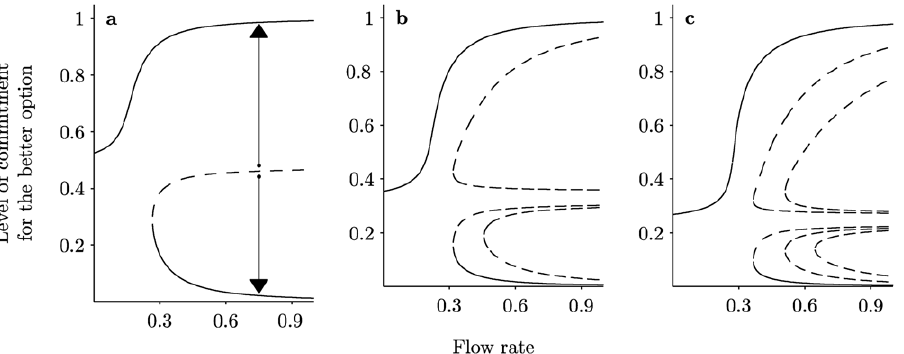
Figure 1. Bifurcation diagrams of x 1 = P n x j corresponding to the steady state level of commitment for the better option (eqs. (3) – j ~ 1 (6))with respect to the flow rate w . (a) case n ~ 2 , (b) n ~ 3 and (c) n ~ 4 . Full and dashed lines correspond to stable and unstable solutions respectively. The stability has been checked numerically by integrating the full eqs. (1) – (2). The arrows indicate the evolution of initial conditions on the two sides of a threshold value corresponding to the intermediate unstable state. Parameter values are 1 ~ 0 : 11 , ~ 0 : 1 , m ~ 2 and n ~ 0 : 01 s { 1 .